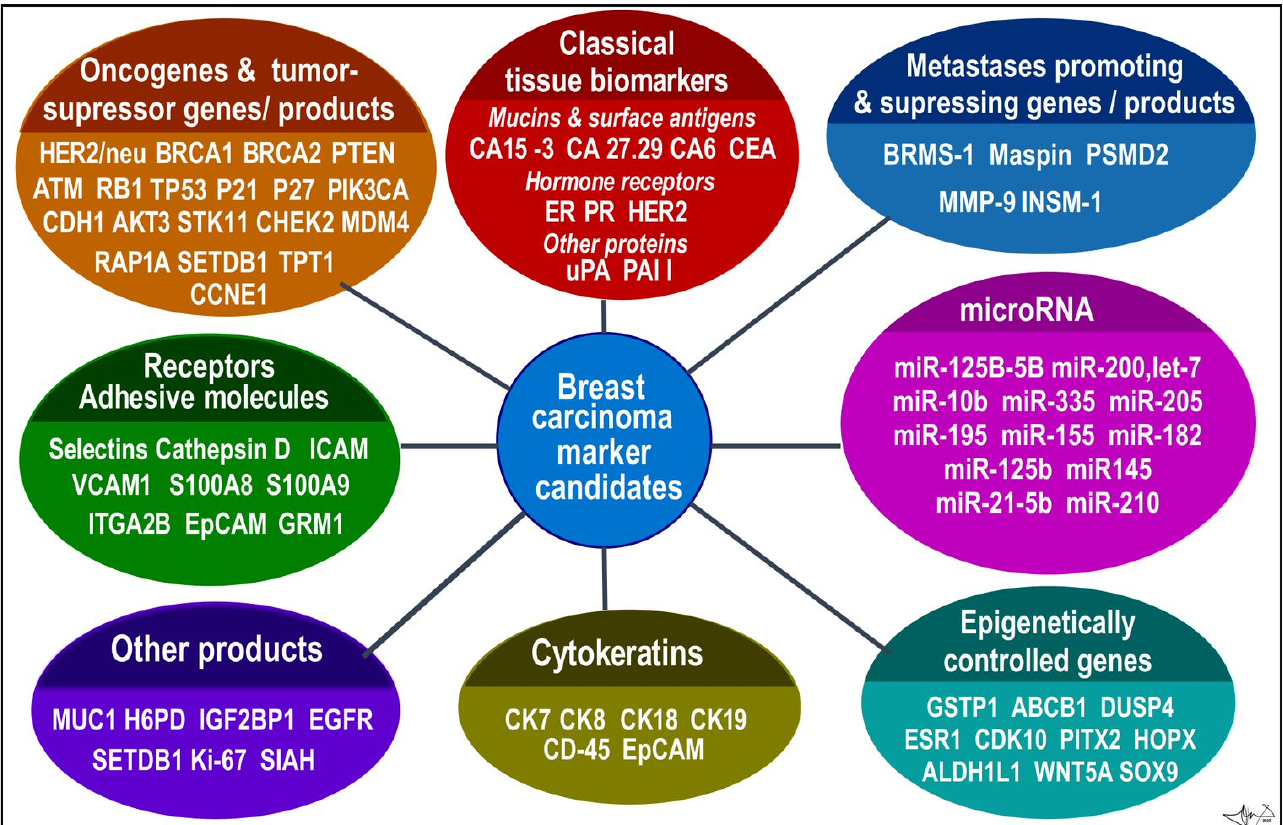
Figure 3. BC candidates arranged according to functional categories. Data were collected from several sources [9,12,13,20,23–25,52,53].